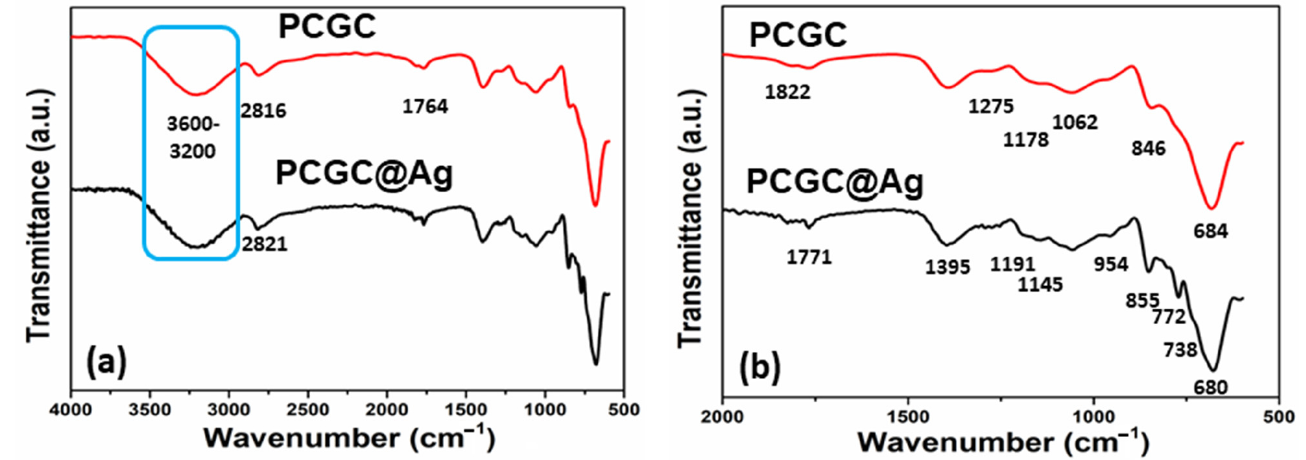
Figure 3. Analysis of the structural and functional groups of the nanofibrous member was performed using FTIR: ( a ) FTIR analysis 4000–500 cm − 1 ; and ( b ) FTIR analysis 2000–500 cm − 1 .